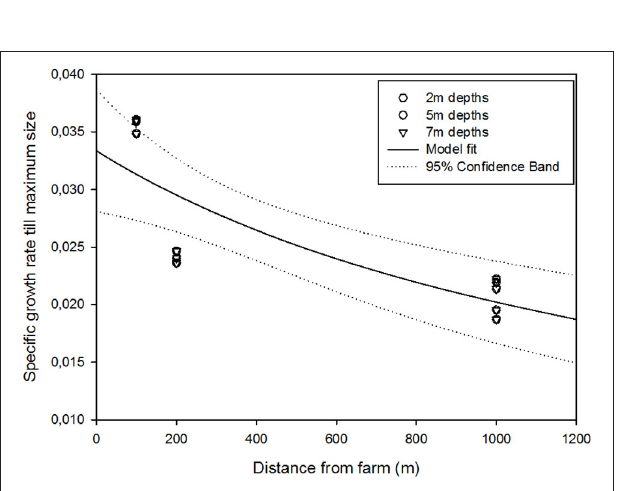
FIGURE 4 | Specific growth rate till maximum kelp size as a function of distance from the farm. Model fitted to data is a hyperbolic decay, 2 parameters, R 2 =